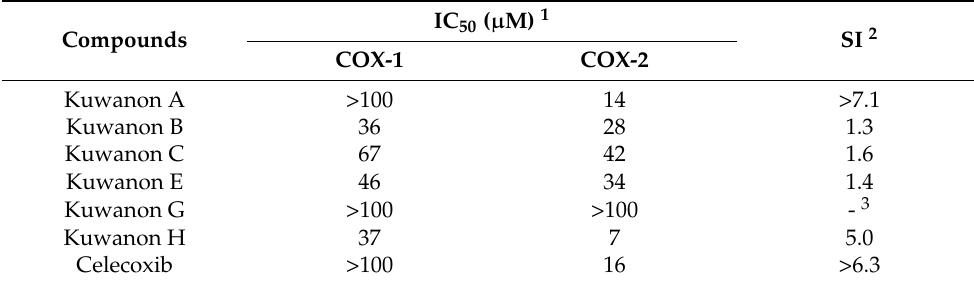
Table 1. Results of the in vitro COX ‐ 1/2 enzyme inhibition assay. Compounds